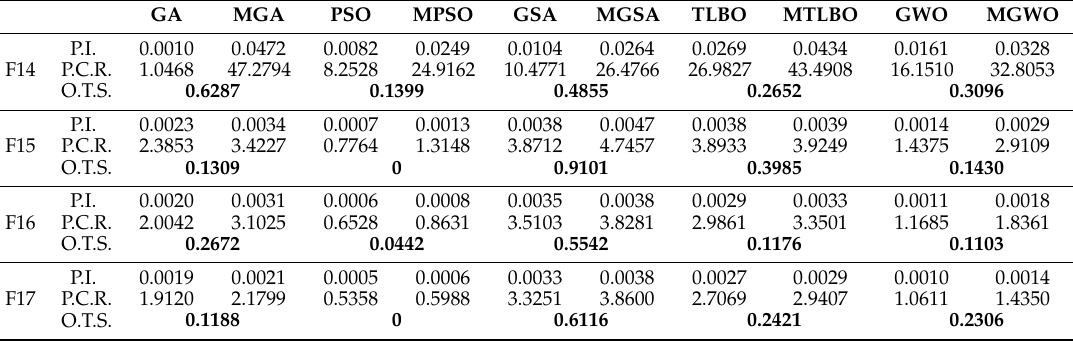
Table 9. Computational time analysis on fixed-dimension multimodal objective functions